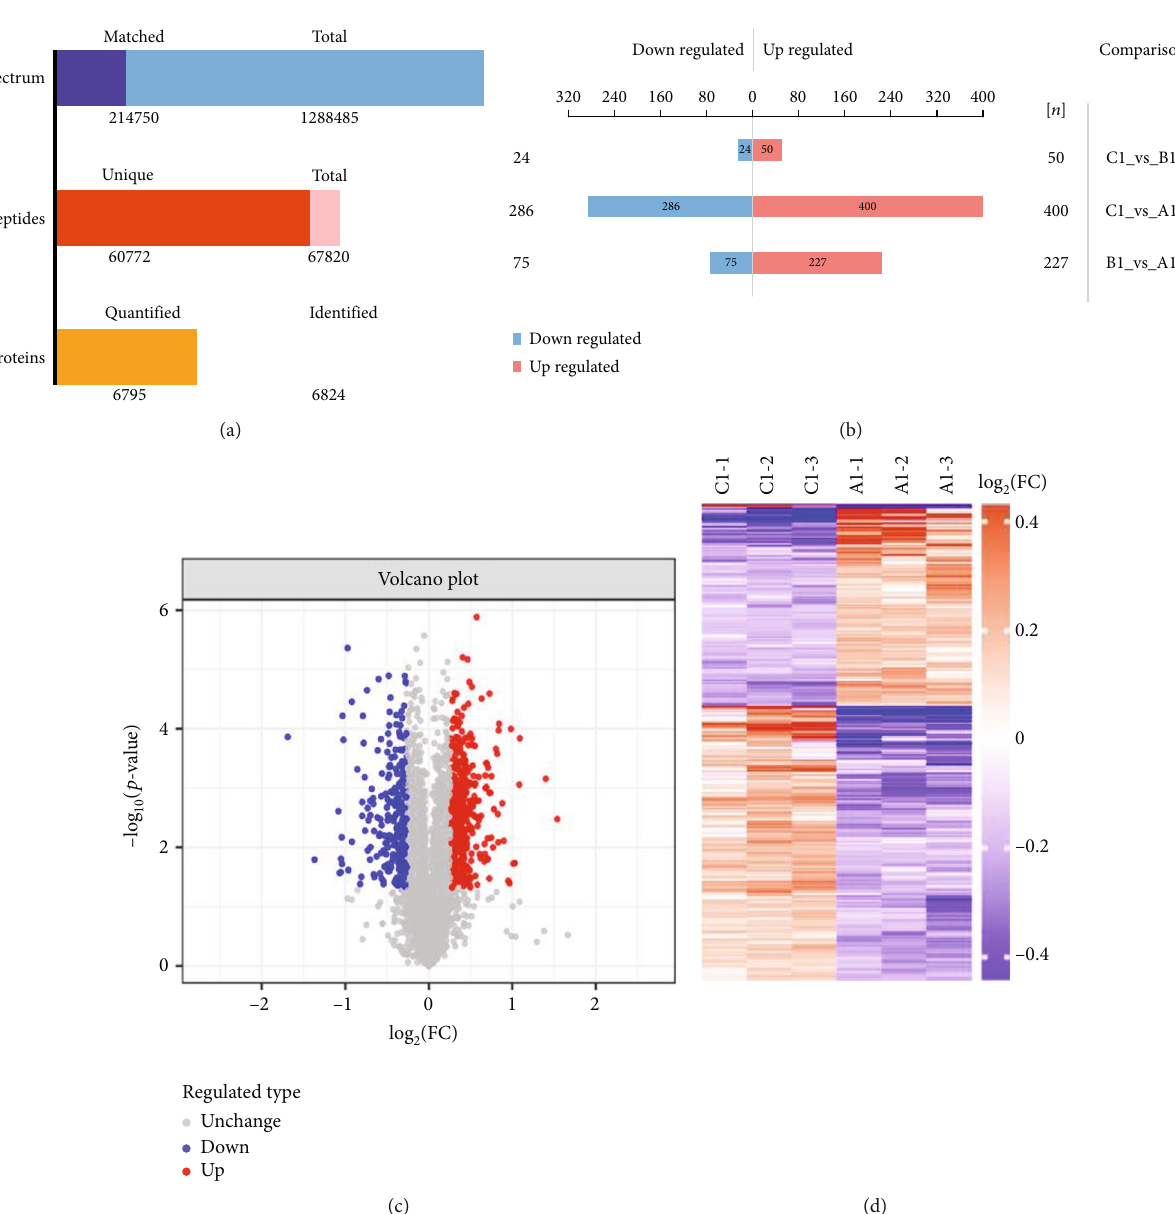
Figure 3: Pro fi ling of di ff erentially expressed proteins between the hypoxia-induced group and the control group. (a) Statistical histogram of protein identi fi cation and quanti fi cation results by TMT. A total of 6824 proteins were identi fi ed, of which 6795 were quanti fi ed. (b) The up- (red) or downregulated (blue) proteins were displayed in di ff erent groups. 74 signi fi cantly di ff erentially expressed proteins were identi fi ed, of which 50 were upregulated and 24 were downregulated after hypoxia induction for 12 hours (group C1), compared to hypoxia induction for 4 hours (group B1). 686 signi fi cantly di ff erentially expressed proteins were identi fi ed, of which 400 were upregulated and 286 were downregulated after hypoxia induction for 12 hours (group C1), compared to the control group (group A1). 302 signi fi cantly di ff erentially expressed proteins were identi fi ed, of which 227 were upregulated and 75 were downregulated after hypoxia induction for 4 hours (group B1), compared to the control group (group A1). (c) Volcano plot showing the up- (red) or downregulated (purple) proteins between the 12-hour hypoxia-induced group (group C1) and the control group (group A1). (d) The hierarchical clustering heat map of di ff erentially expressed proteins between the 12-hour hypoxia-induced group (group C1) and the control group (group A1). Each column represents a set of samples, while each row represents a protein in the fi gure. The red represents signi fi cantly higher proteins, while purple represents signi fi cantly lower proteins in the heat map; the gray part means quantitative information without